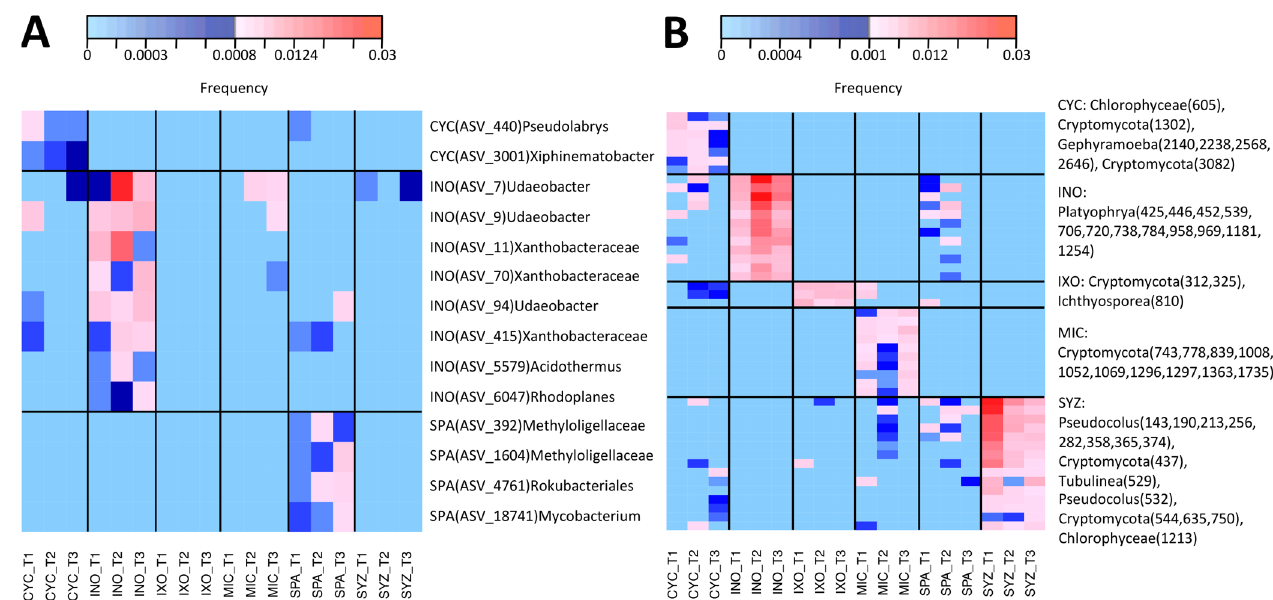
Figure 7. Heatmap of specific bacterial and microeukaryote ASVs in the tree stage. Only ASVs specific to a single plant species are shown. For each ASV number, the name of the associated plant species is indicated as well as its taxonomic annotation. CYC: Cyclophyllum barbatum , INO: Inocarpus fagifer , IXO: Ixora mooreensis , MIC: Miconia calvescens , SPA: Spathodea campanulata , SYZ: